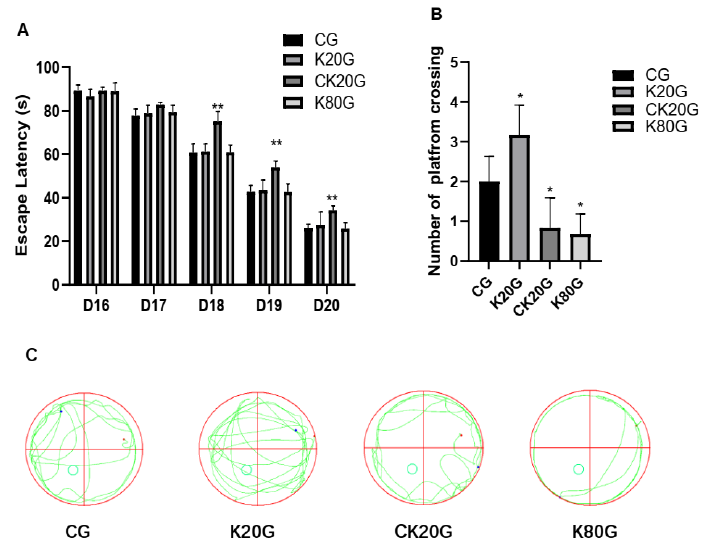
Figure 1. Effect of different doses of ketamine on the behavior of rats. ( A ) Escape latency from D16 to D20. Different treatment groups are compared with the control group on each day. ( B ) The number of platform crossings at the 24th hour after ketamine injection. ( C ) Swimming path tracks at the 24th hour after ketamine injection. Data are expressed as means ± SD. * p < 0.05 and ** p < 0.01 versus